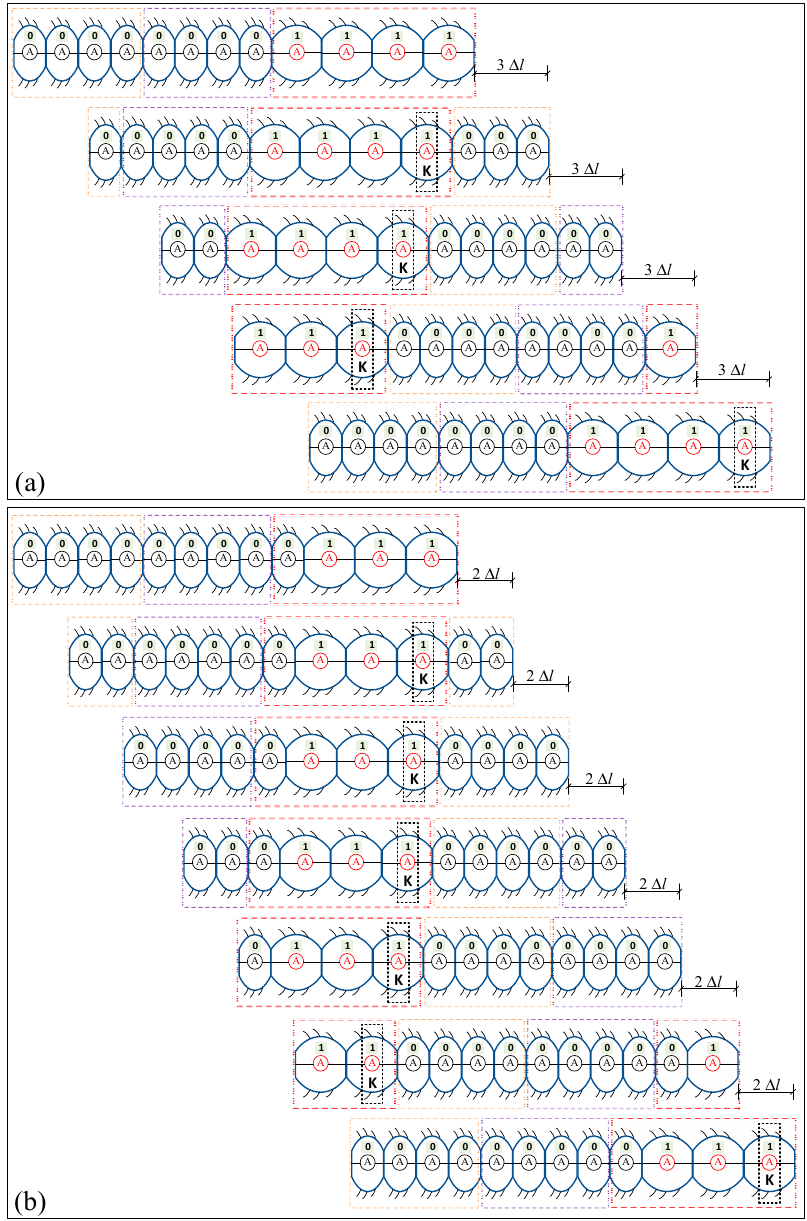
Figure 8. The gait generation demonstrations for a 12-segment robot with two different driven modules with MG-II. The “K” indicates keeping the previous state segments. A gait generation demonstration for a 12-segment robot under U-DM is shown in ( a ). The frequency of the receding peristaltic wave is 1/4. The amplitude of the receding peristaltic wave is 3. A gait generation demonstration for a 12-segment robot under B-DM (“0111”) is shown in ( b ). The frequency of the receding peristaltic wave is 1/6. The amplitude of the receding peristaltic wave is 2. Regarding the gait generation in Figure 8a for a 12-segment robot under U-DM with four actuated segments, there is a “K” segment when transmitting the three segments every time. The number of transmission segments is equal to three-quarters of the module phase difference. The number of body segments in the U-DM equals the sum of the number of transmission segments and the number of “K” segments. The earthworm-like locomotion robot advances 3 ∆ l with each transmission of the U-DM. In this gait module mode, locomotion speed depends only on the number of transmission